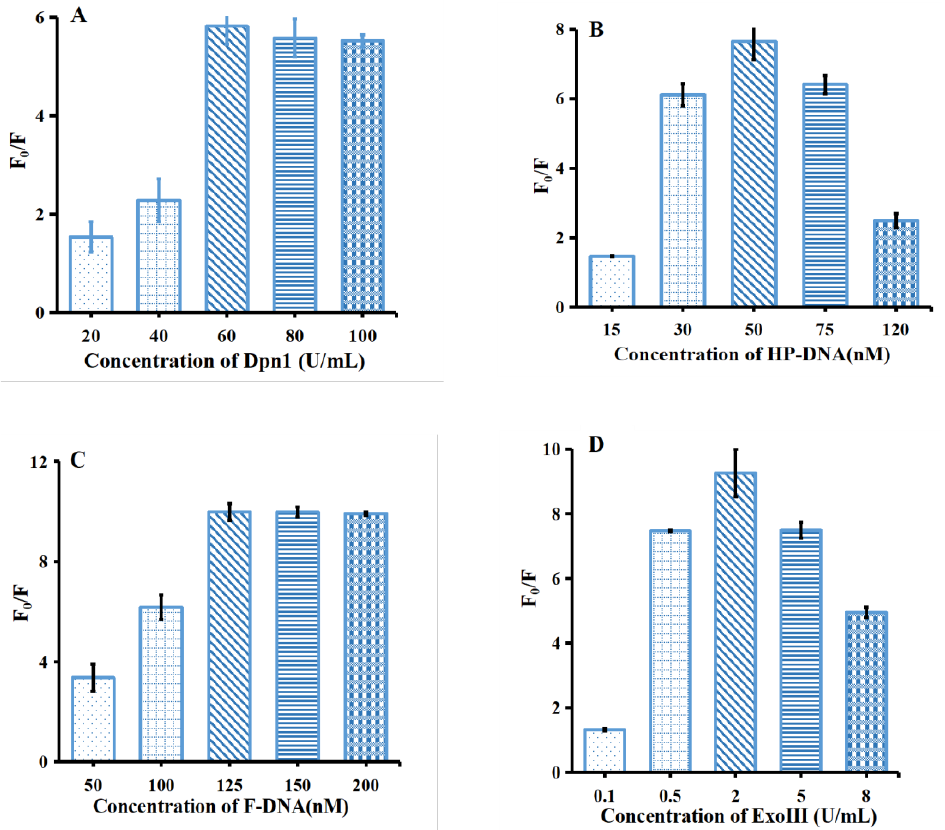
Figure 2. Optimization of experimental conditions. ( A ) concentrations of DpnI (20, 40, 60, 80, 100 U/mL); ( B ) concentrations of HP-DNA (15, 30, 50, 75, 120 nM); ( C ) concentration of F-DNA (50, 150, 125, 150, 200 nM); ( D ) concentrations of Exo III (0.1, 0.5, 2, 5, 8 U/mL). Error bars were calculated from three replicate measurements. F 0 and F were the fluorescence ratio of the detection system without and with MTase, respectively.